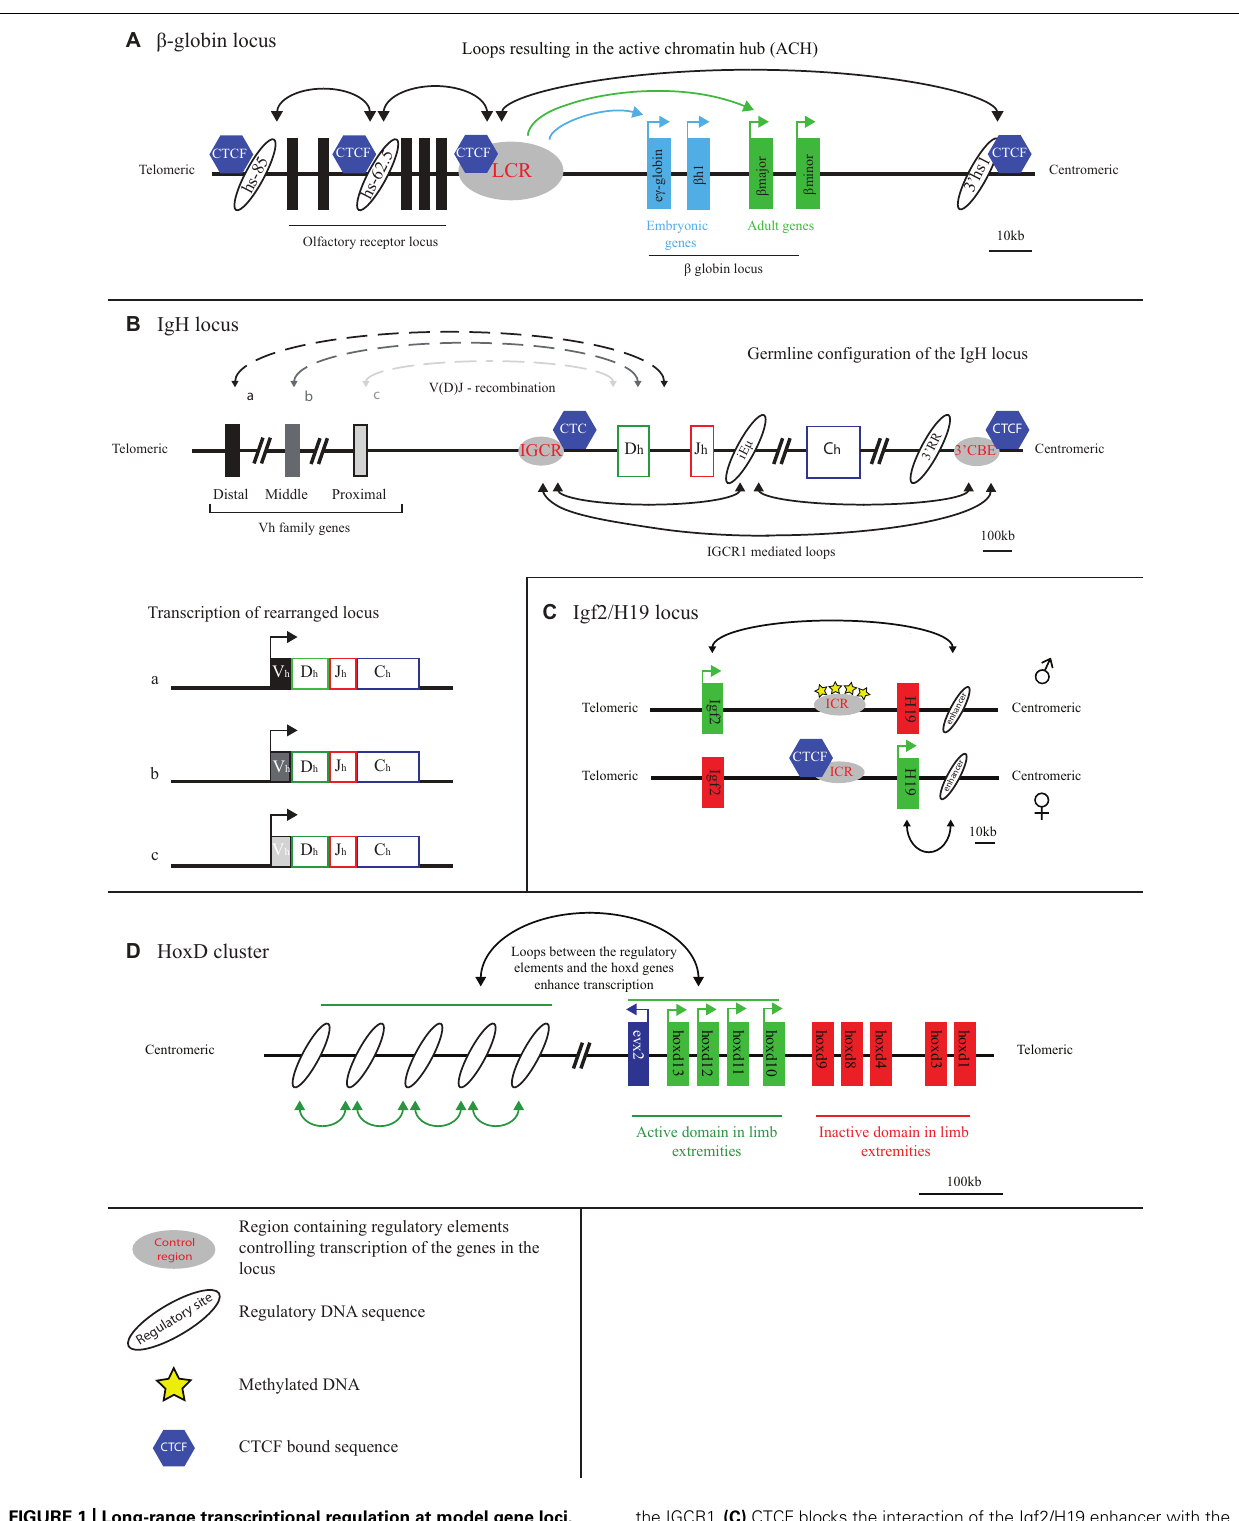
FIGURE 1 | Long-range transcriptional regulation at model gene loci. (A) At the active β -globin locus, LCR–gene contacts and interactions between flanking CTCF sites set up an active chromatin hub (ACH). (B) The IGCR1 contacts the 3 (cid:3) regulatory region and the intronic enhancer of the IgH locus in pro-B cells. Inclusion of the distalV genes is influenced by the presence of